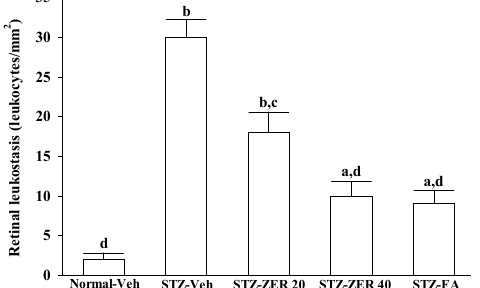
Figure 4. Effects on retinal leukostasis. STZ-diabetic rats were administered 20 mg/kg/day zerumbone (STZ-ZER 20), 40 mg/kg/day zerumbone (STZ-ZER 40) or 100 mg/kg fenofibric acid (STZ-FA) by oral gavage once daily for three months. Another group of STZ-diabetic rats (STZ-Veh) and normal rats (Normal-Veh) were administered the same volume of vehicle used to prepare the test medication solutions. The total number of adherent leukocytes per retina was counted. Data are mean ± SD from eight rats per group, and the experiments were repeated independently at least three times with similar results. a p < 0.05 and b p < 0.01 compared to vehicle-treated normal rats, respectively; c p < 0.05 and d p < 0.01 compared to the values of vehicle-treated STZ-diabetic rats,